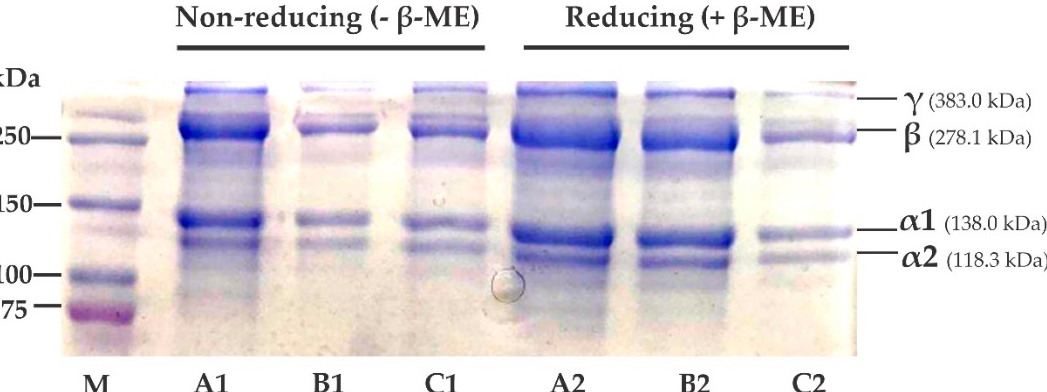
Figure 1. SDS-PAGE image of acid soluble unicornfish bone collagen. M: protein marker; A1 and A2: acetic acid soluble collagen (AASC); B1 and B2: lactic acid soluble collagen (LASC); C1 and C2: citric acid soluble collagen (CASC).